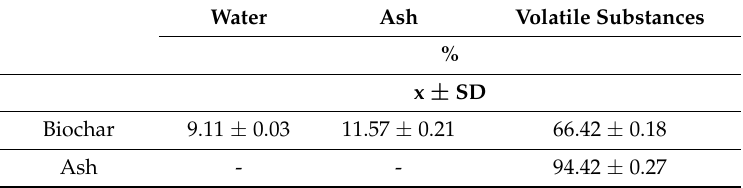
Table 3. Contents of selected macro- and microelements in biochar and ash from biomass. Al